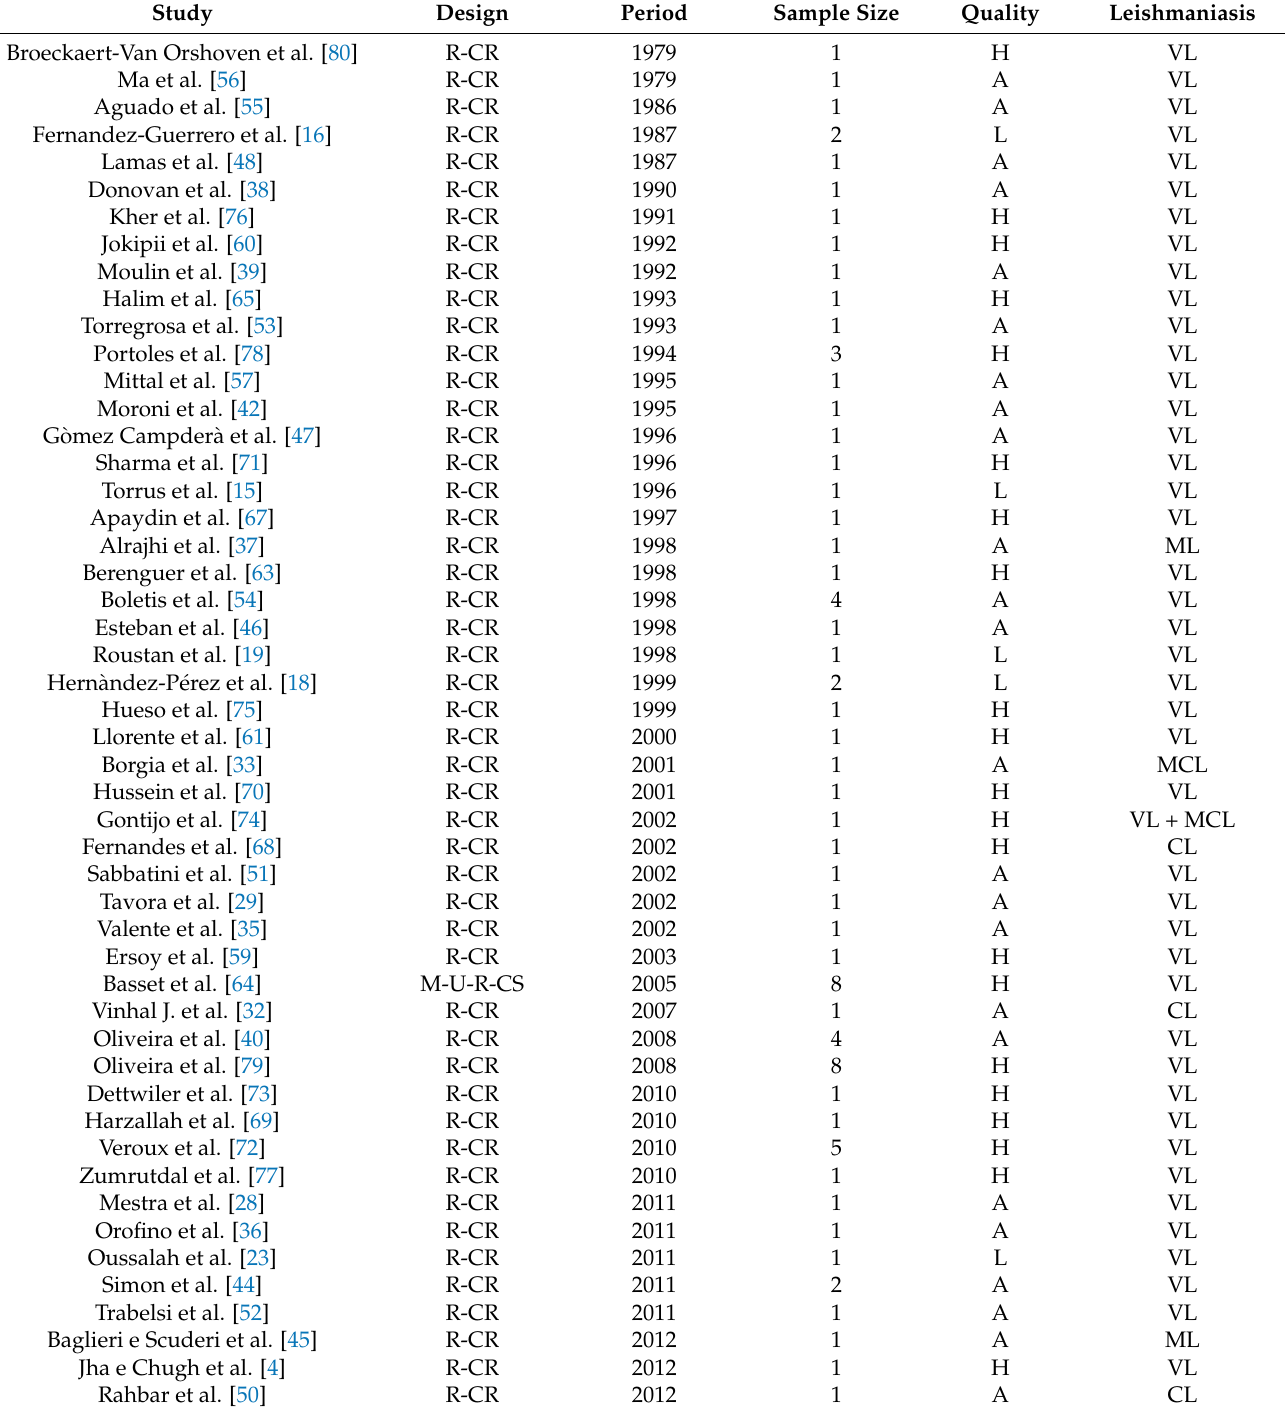
Table 1. Characteristics of studies meeting the criteria for the systematic